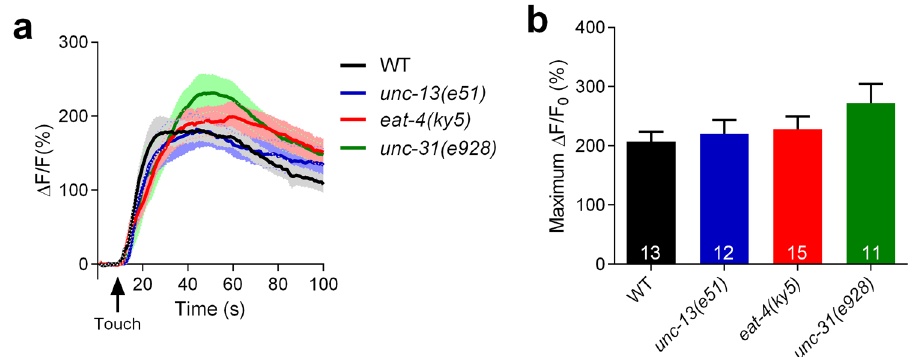
Figure 3. Touch-induced calcium responses in RnB neurons do not rely on synaptic transmission. ( a , b ) Averaged calcium responses ( a ) and maximum Δ F/F0 changes ( b ) in R1B-R3B neurons induced by mechanical stimulation of 15 μ m displacement at the position of rays 1–3 in wild type, unc-13(e51) mutants, unc-31(e928) mutants and eat-4(ky5) mutants. Solid lines show the average fluorescence changes and the shading indicates SEM. n ≥ 12. Data are mean ±